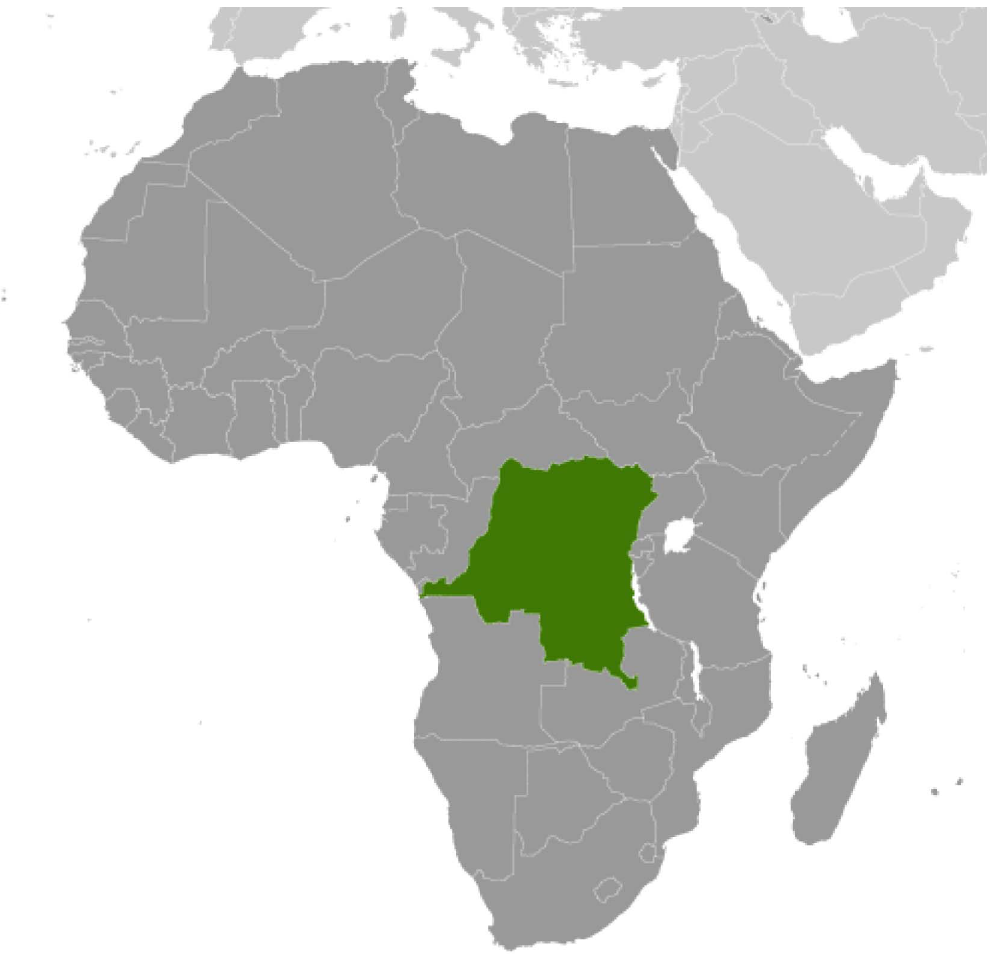
Figure 1. Map and location of the Democratic Republic of Congo. From CIA Factbook, https://www.cia.gov/library/publications/the-world- factbook/maps/cg_largelocator_template.html, accessed December 31, 2012.